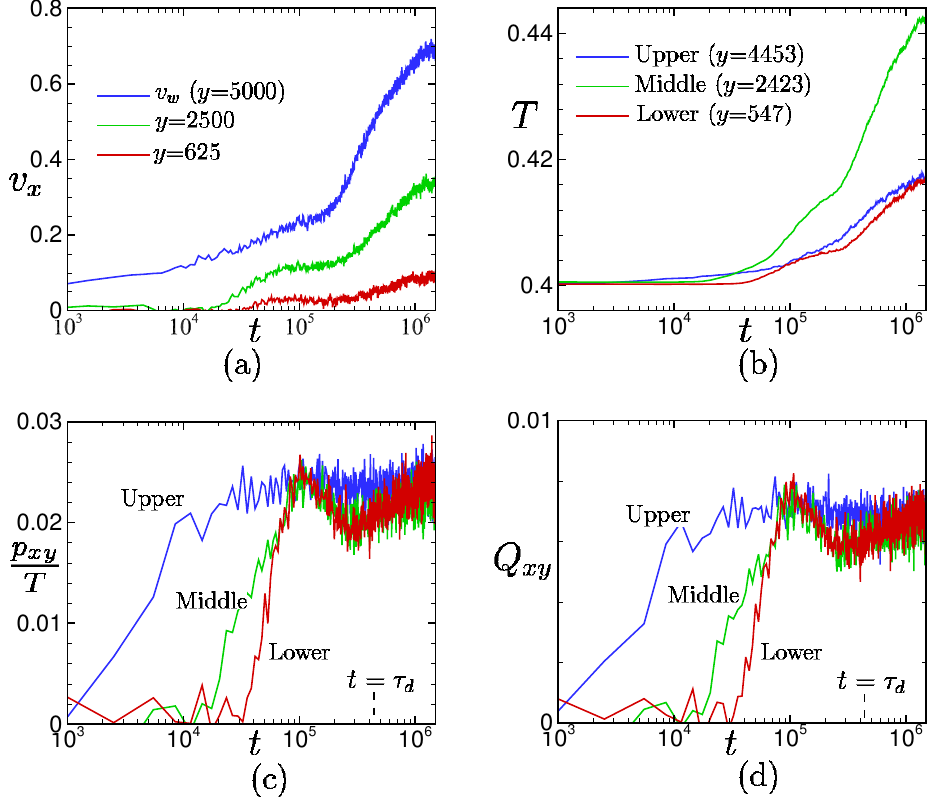
Figure 9. Time evolutions of ( a ) local velocity, ( b ) temperature, ( c ) shear stress, and ( d ) bond orientation for the drive force p w = 0.01. The upper-wall velocity v w and local velocities at y = 2500 and 625 are shown in ( a ). The local temperatures, local shear stresses, and local bond orientations at the upper ( y = 4453), middle ( y = 2423), and lower ( y = 547) regions between the walls are shown in ( b – d ), respectively. The vertical dashed line on the horizontal axis shows the disengagement time of entangled polymer chains in the quiescent